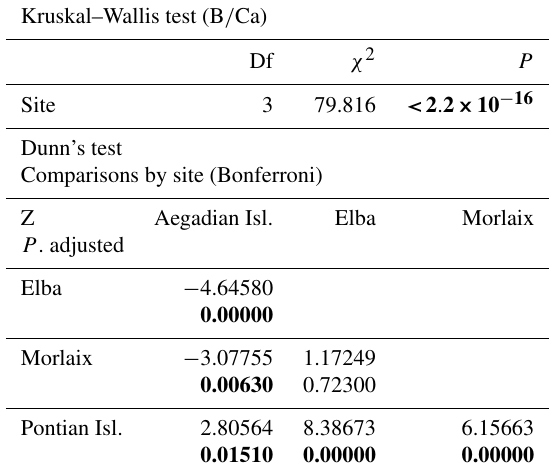
Table A3. Results of statistical tests performed to evaluate the differences of B / Ca in L. corallioides collected at different sampling sites. Statistically significant p values are given in bold. Kruskal–Wallis test significance at α = 0 . 05; Dunn’s test significant at p ≤ α/